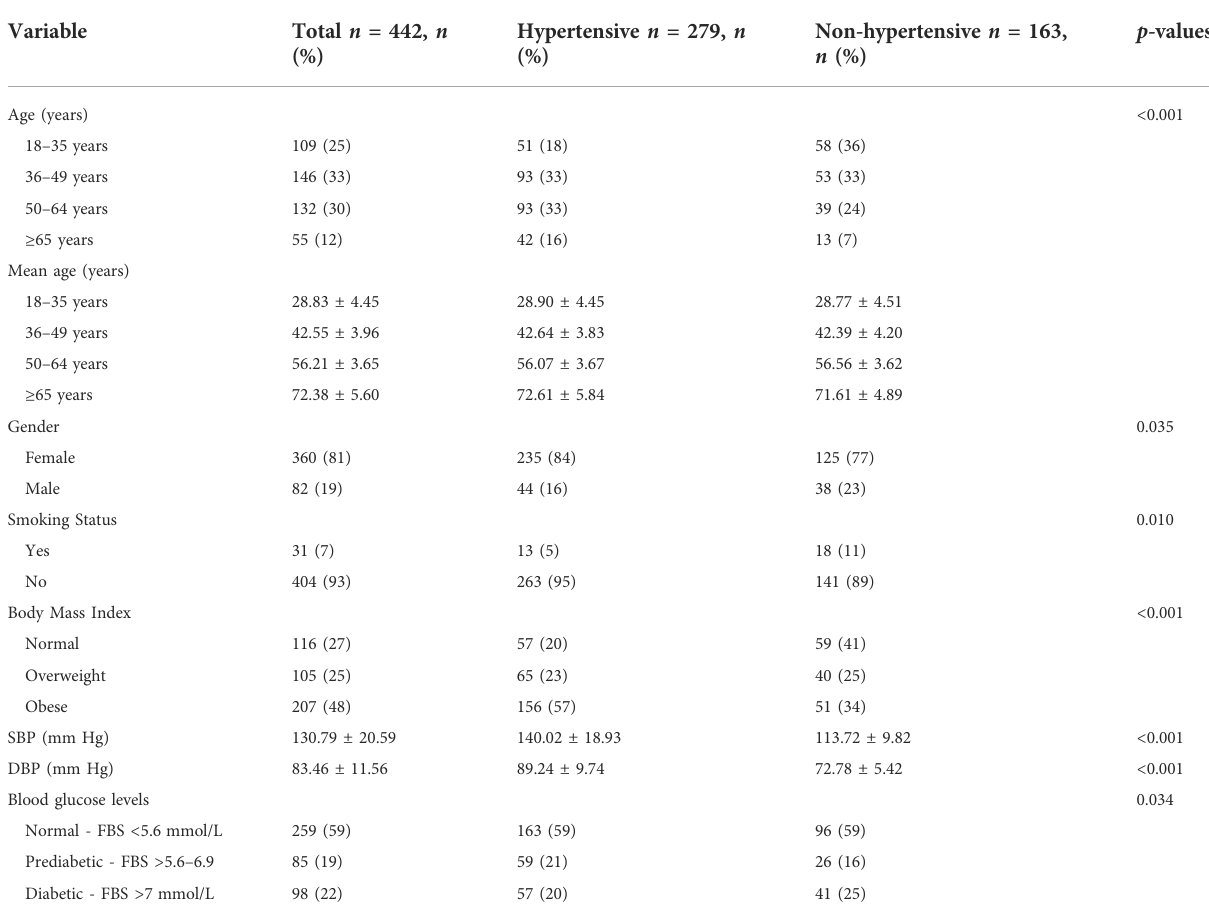
TABLE 1 General characteristics of the study